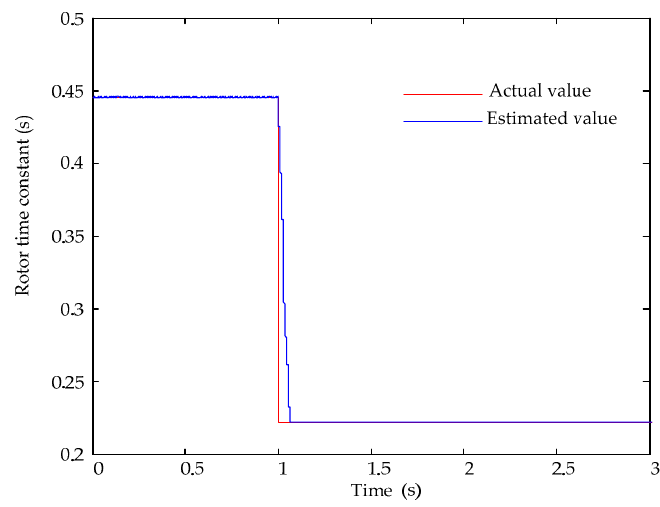
Figure 13. Estimated rotor time constant of the IM using the model reference adaptive system method, where the rotor resistance was changed at t = 1 s.